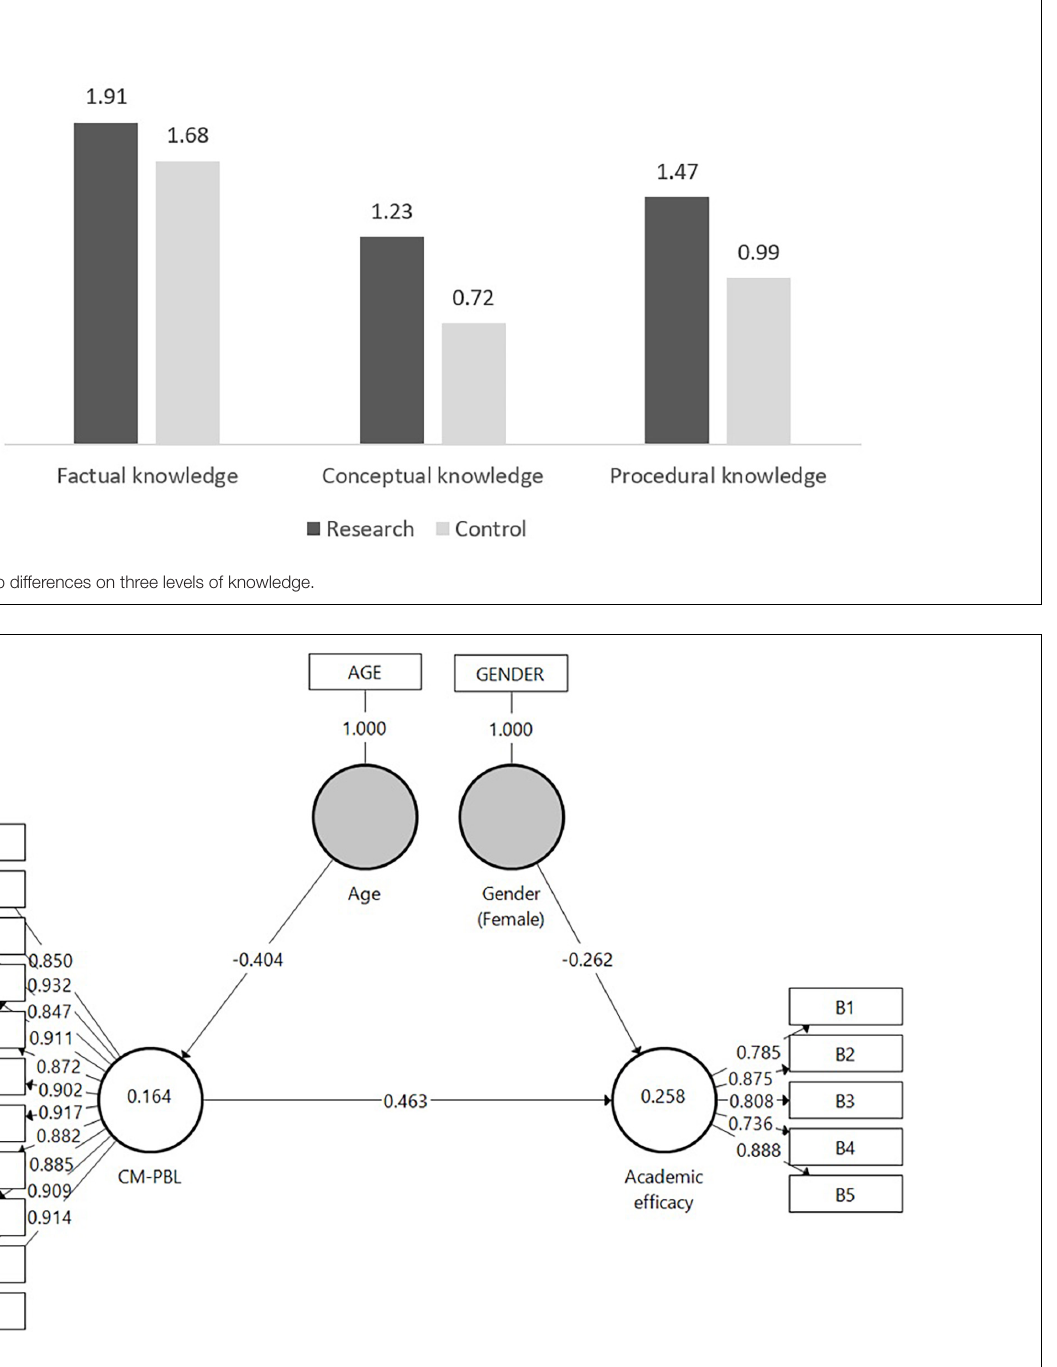
FIGURE 4 | Model 1 analysis results of the examination of H2 by